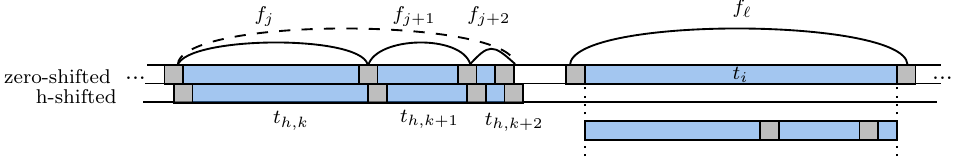
Figure 2. A phrase-aligned copy f j f j + 1 . . . f j (cid:48) of f (cid:96) and the corresponding copy t h , k d h , k t h , k + 1 d h , k + 1 . . . d h , k (cid:48) − 1 t h , k (cid:48) of t i in the h -shifted block parsing. Gray and blue rectangles